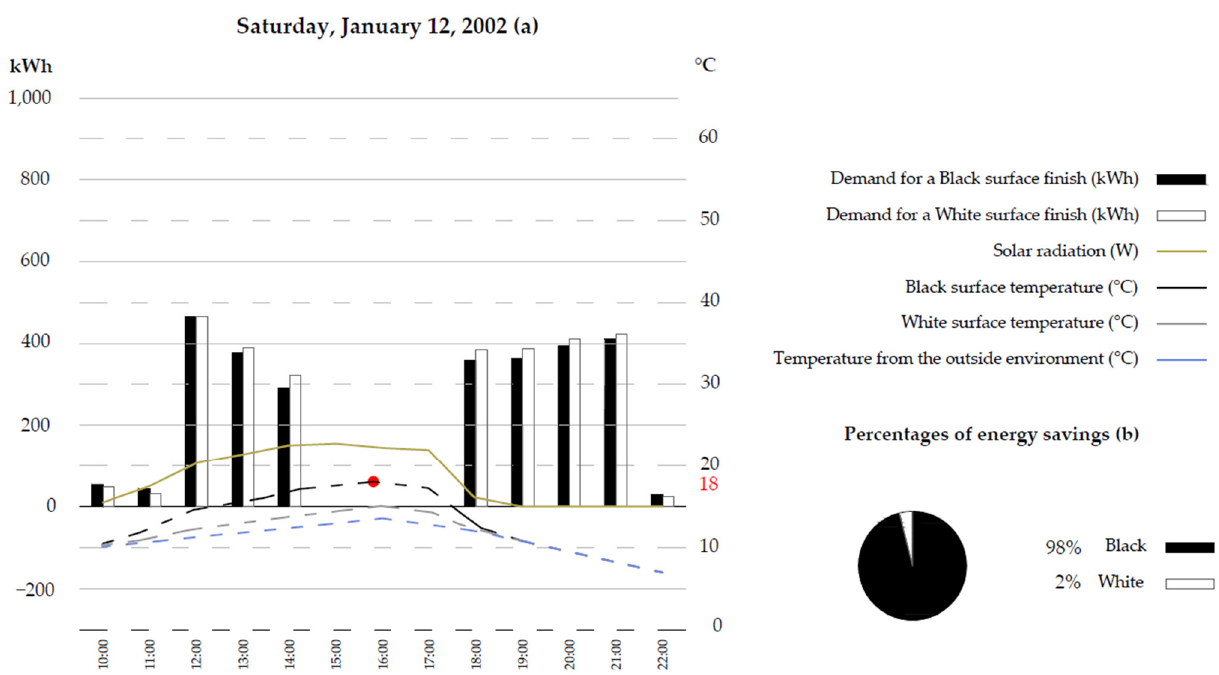
Figure 18. ( a ) Surface temperature and energy performance for 12 January 2002, in Madrid. ( b ) White vs. black surface finish energy savings.